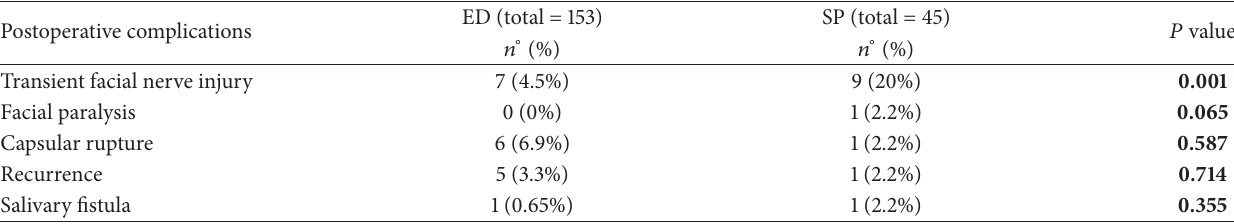
Table 2: Differences of the recurrent rates and complications of ED versus